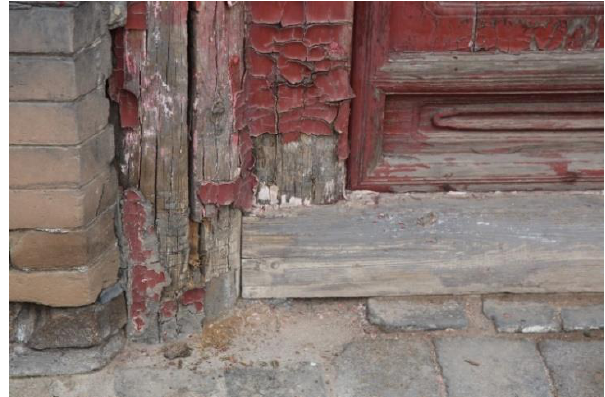
Figure 15 pillar cracks of the temple gate